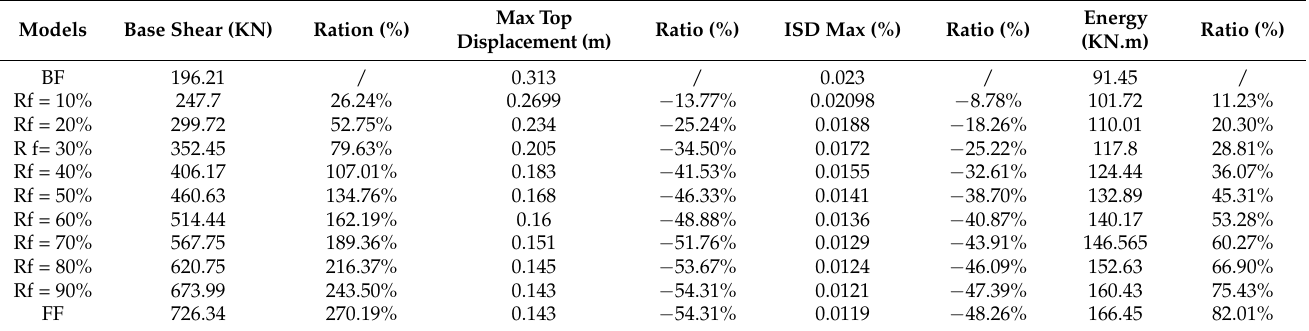
Table 4. Summary of the obtained results: the values of maximum top displacement, maximum base shear, maximum inter-story drift and the energy for all models are attributed to their corresponding values in the bare frame